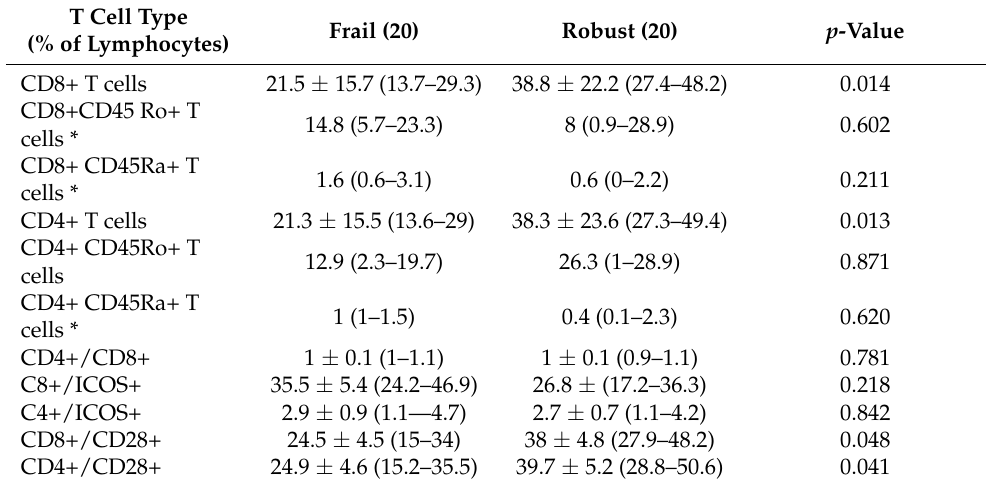
Table 2. T cell phenotypes in frail and robust older subjects. Mean and SD values with CIs are shown for Gaussian variables. Median, 25th and 75th percentiles are shown for non-Gaussian variables, indicated with an asterisk (*). p -values were calculated by one-way ANOVA for Gaussian variables and by the Mann-Whitney U test for non-Gaussian variables.